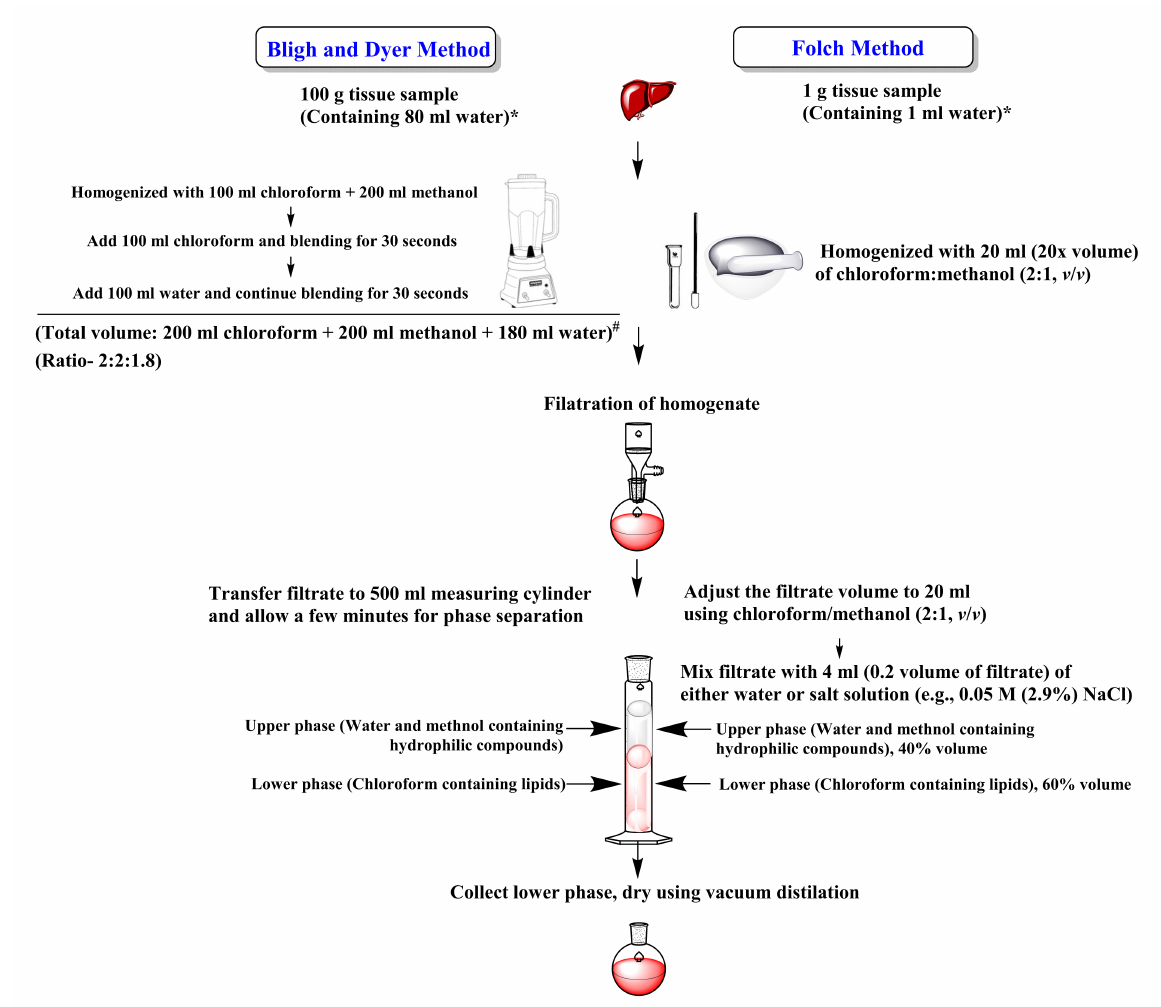
Figure 1. Comparison of Bligh and Dyer method [8] and Folch method [7] of lipid extraction. * Assumption of 100% or 80% water in the sample. # For quantitative analysis, re-extraction of residues with 100 mL chloroform and rinsing with 50 mL chloroform is